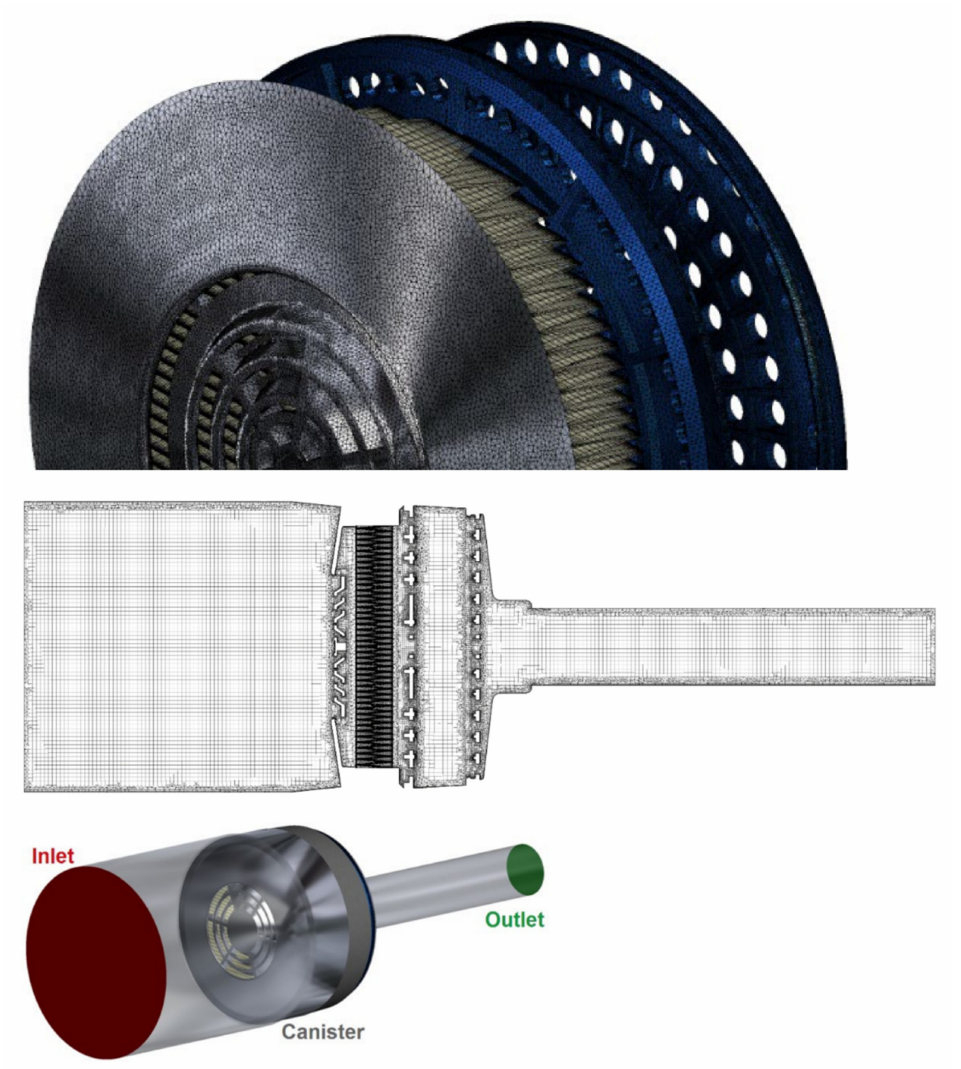
Figure 4. Detail of surface computational grid ( top ), cross section of computational mesh ( middle ) and boundary conditions ( bottom